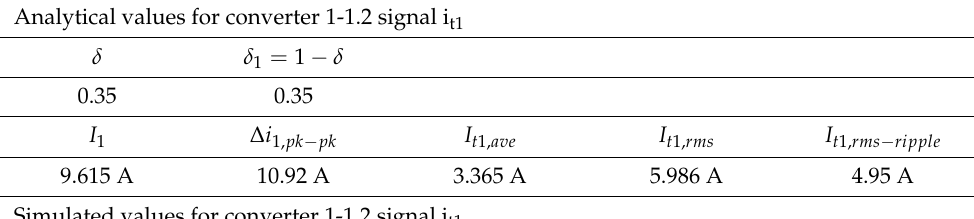
Table 2. Analytical and simulated data for converter 1-1.2 when in CCM.